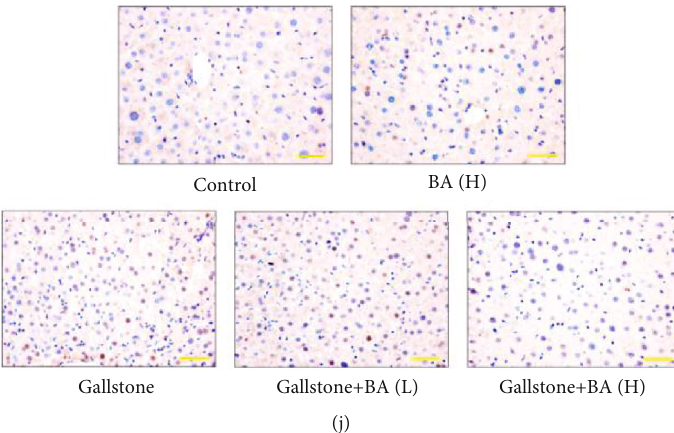
Figure 3: Lithogenic diet induced disorders of cholesterol synthesis and transport in liver. (a – c) The mRNA levels of cholesterol 7 α - hydroxylase (CYP7a1) (a), sterol 12 α -hydroxylase (CYP8b1) (b), and liver X receptor α (LXR α ) (c) in the liver were detected by real-time PCR. (d) Western blot was used to measure the protein levels of CYP7a1, CYP8b1, adenosine triphosphate binding cassette (ABC)G5, ABCG8, and LXR α in the liver of mice that received a lithogenic diet or Baicalin administration. (e – i) Quantitative analysis of CYP7a1 (e), CYP8b1 (f), ABCG5 (g), ABCG8 (h), and LXR α (i) of immunoblotting bands in (d). (j) Immunohistochemistry staining was used for detection of LXR α expression in the liver (the scale bar represented 50 μ m). n = 6 ( ∗ p < 0 : 05 , ∗∗ p < 0 : 01 , and ∗∗∗ p < 0 : 001 ). ns: no signi fi cance; BA(L): 50mg/kg baicalin; BA(H): 100mg/kg